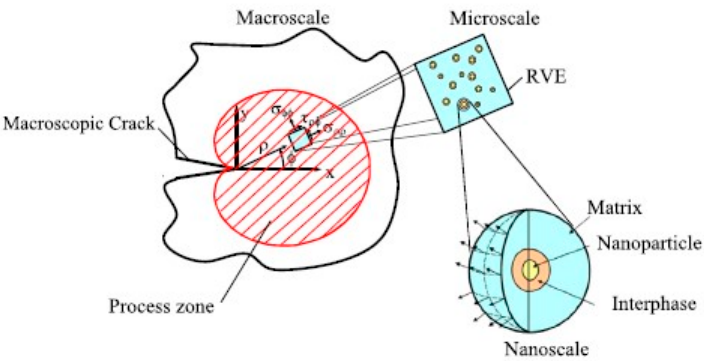
Figure 8. Description of the multiscale system for the assessment of the fracture toughness of nanoparticle filled polymers